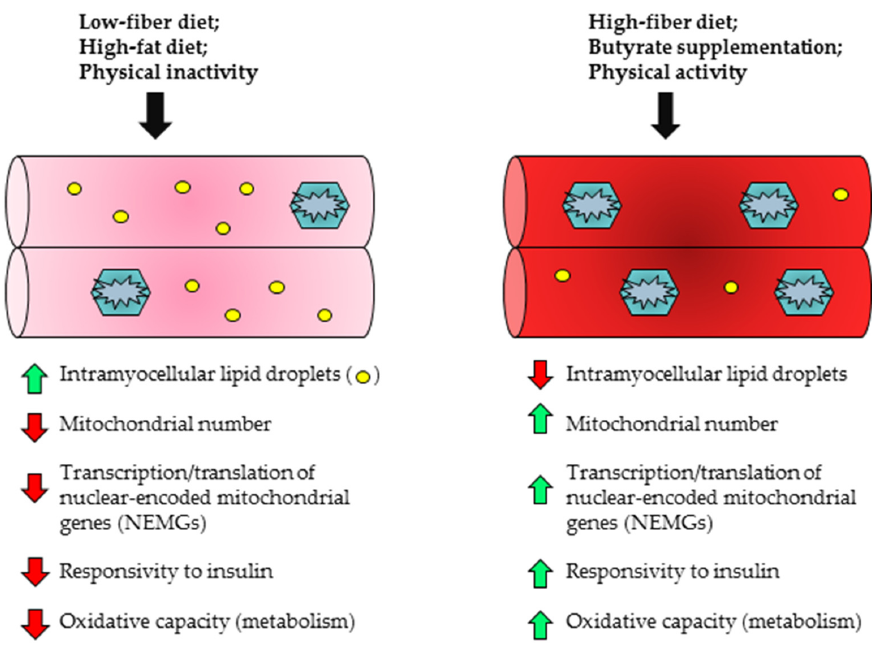
Figure 2. Effects of butyrate on skeletal muscle physiology.